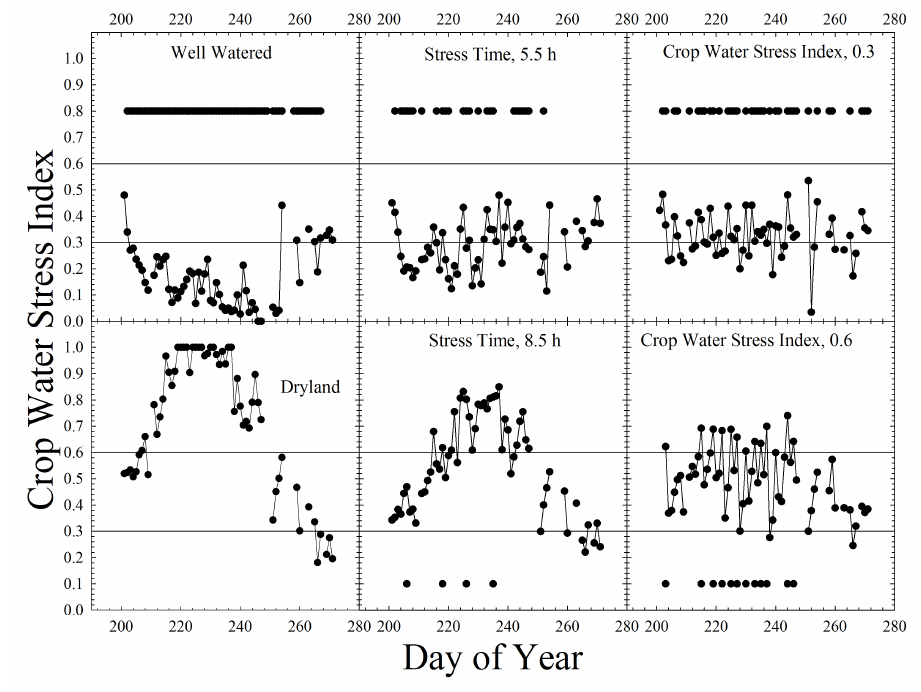
Figure 4. Average midday (12.00 to 15.00 h) Crop Water Stress Index calculations for six water treatments vs. day of year. Vertical lines, drawn for comparison across treatments, at 0.3 and 0.6 indicate Crop Water Stress Index thresholds for triggering an irrigation event in the CWSI_0.3 and CWSI_0.6 treatments, respectively. Filled circle symbols at the bottom or top of the panels indicate days when irrigation was triggered. For the Stress Time and the Crop Water Stress Index treatments, 5 mm of water was applied at each irrigation event. Irrigation amounts in the well watered (WW) represent 110% of calculated potential evapotranspiration during the previous time interval. The dryland treatment (DL) received no